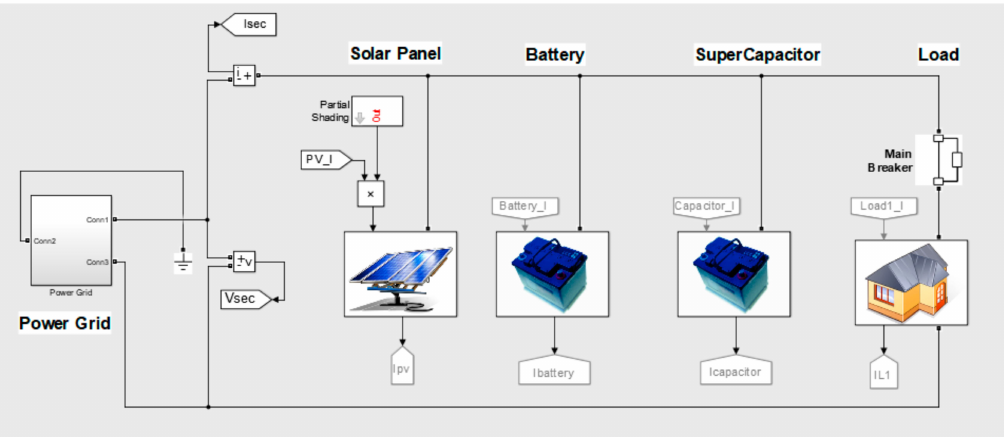
Figure 3. Simulink model of generic hybrid PV-storage system.